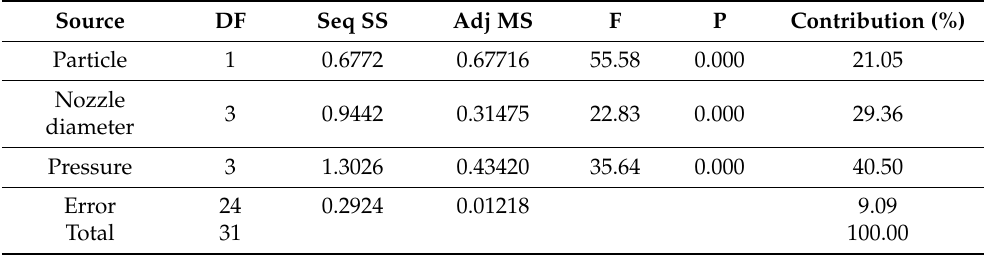
Table 2. The pre-tested results for main factors and conditions.